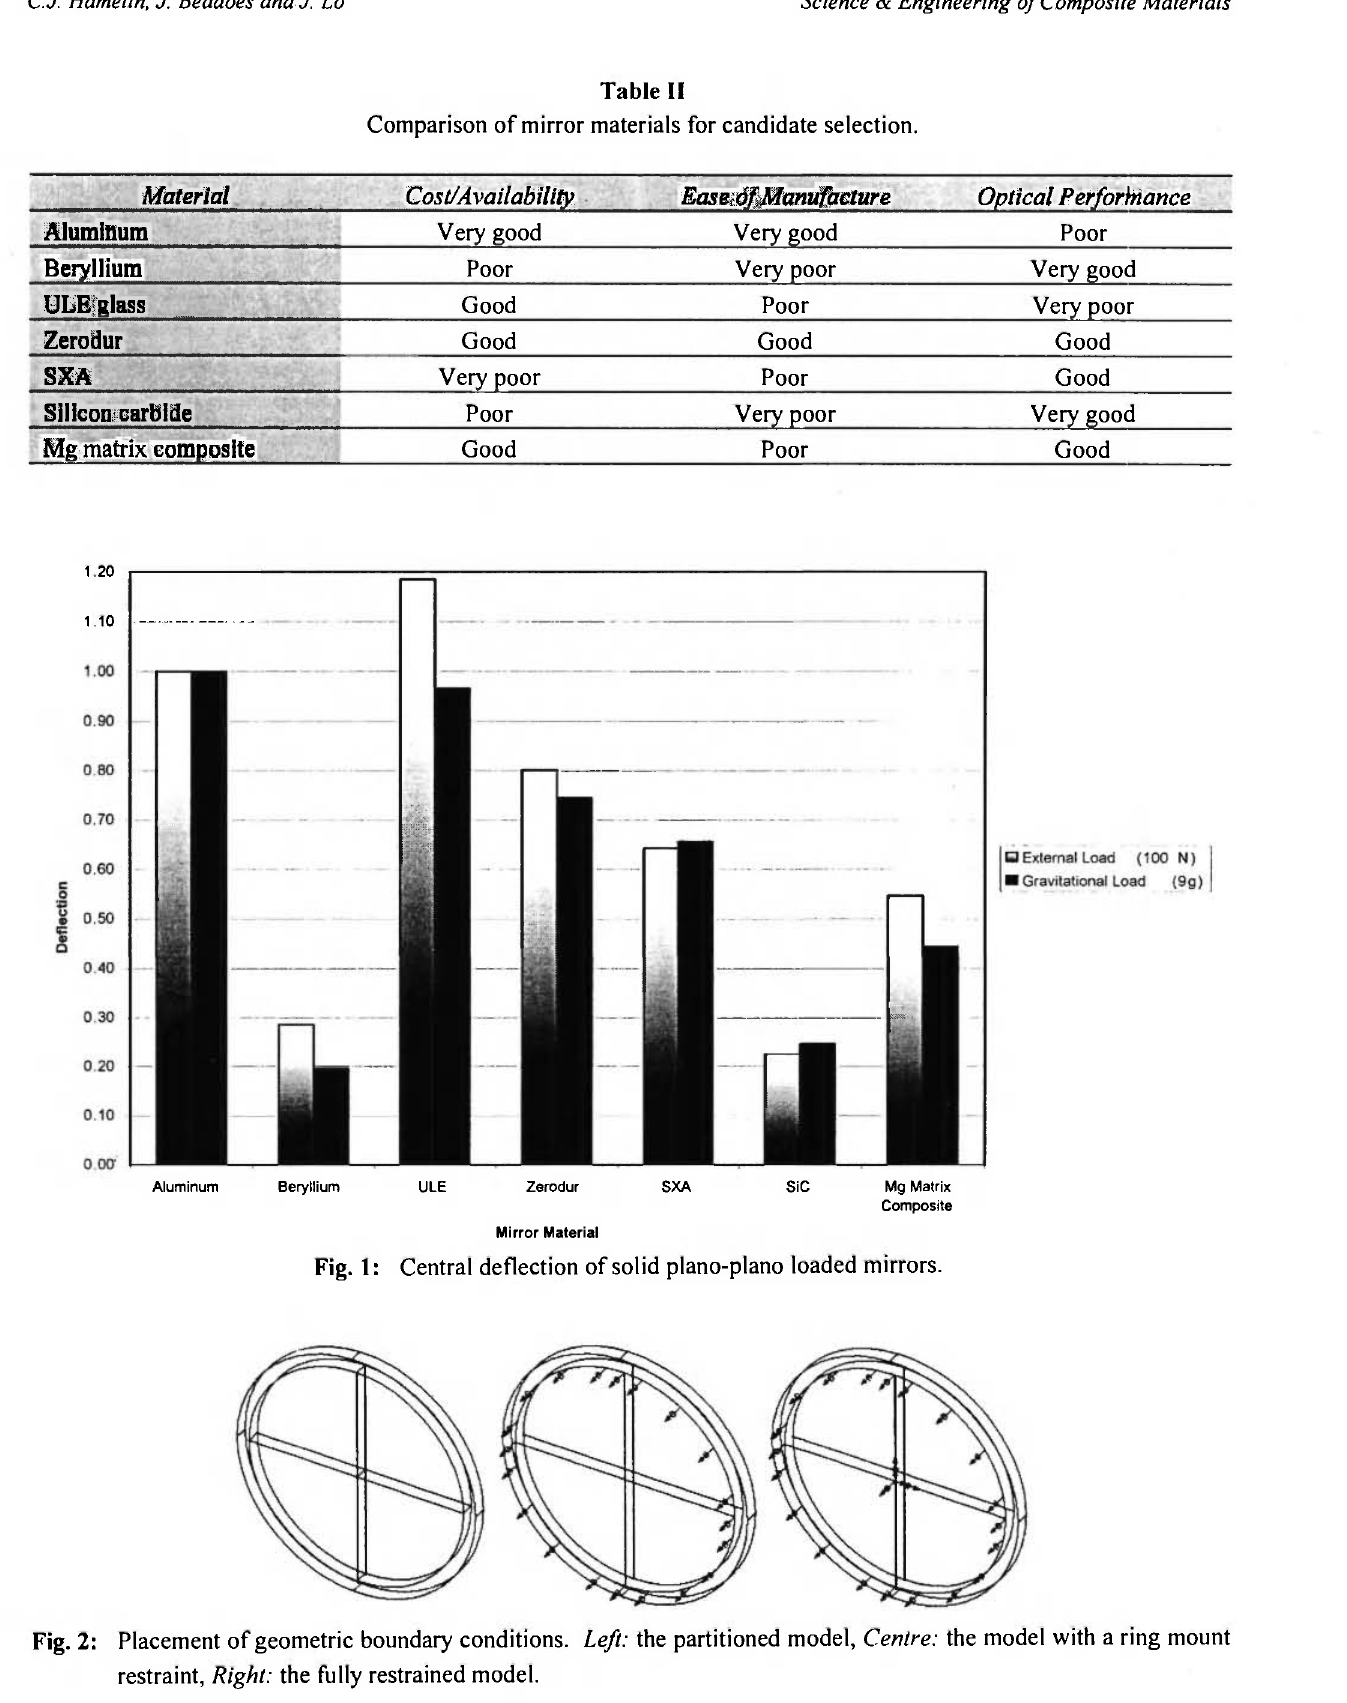
Comparison of mirror materials for candidate selection.